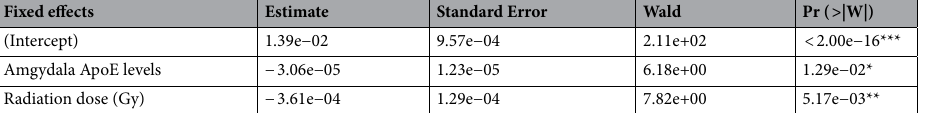
Table 7. Linear generalized estimating equations model results predicting relative hippocampal volumes with ApoE levels in the amgydala and radiation dose as independent predictors. *** p < 0.001, ** p < 0.01, * p < 0.05; displayed p -values are uncorrected for multiple